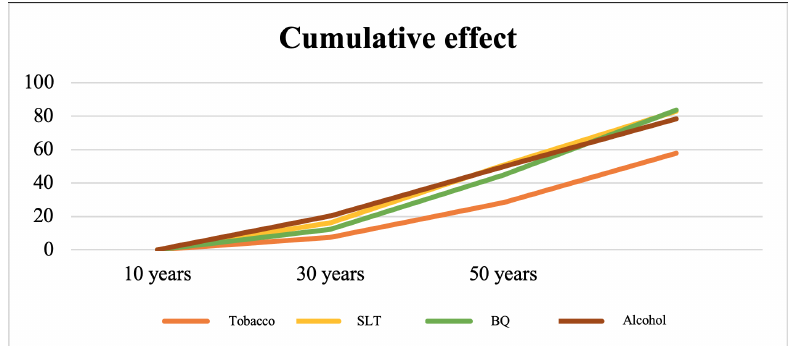
Figure 3. Cumulative effect of duration of exposure to the occurrence of